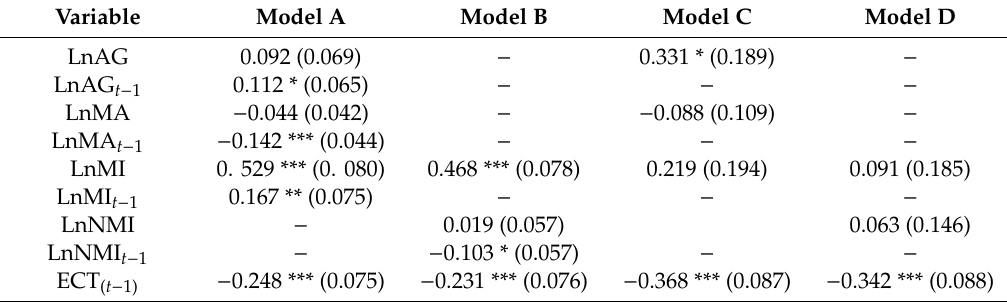
Table 7. Short − run elasticities of economic growth between 1980–2017